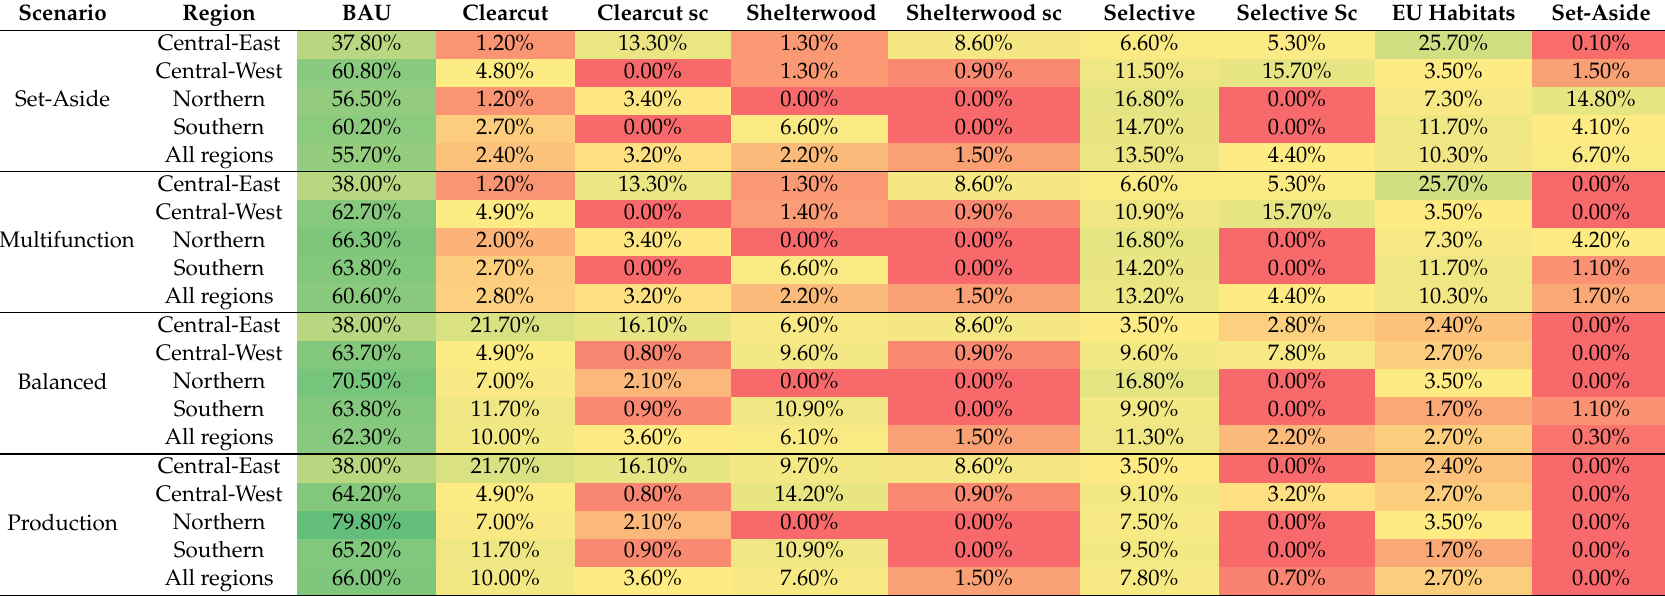
Table 3. Share of FMMs implemented within the total forest area in each region for the aFMM allocation scenarios (business as usual (BAU)—only standard G4M FMMs are applied; sc indicates that tree species change is applied in the considered aFMM; colors highlight the relative shares of FMMs within each region, from the lowest (red) to the highest